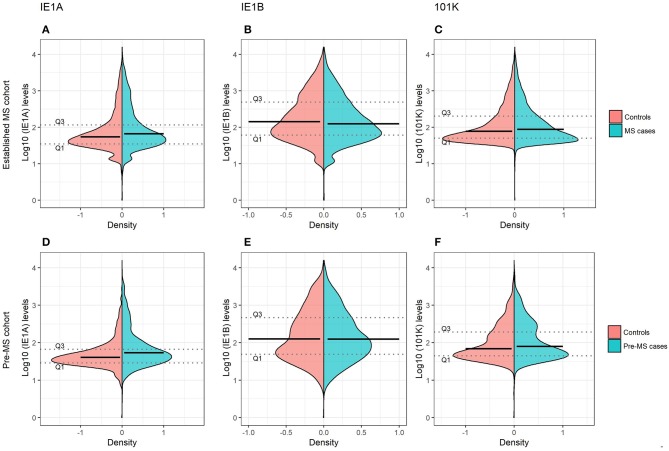
Antibody responses against HHV-6A and 6B proteins in MS cases and controls. Log10-transformed antibody levels measured as median fluorescence intensity (MFI) are visualized with bean plots for established MS cohort [n = 8,742 persons with MS (blue) and n = 7,215 controls (pink)] (A–C) and pre-MS cohort [n = 478 persons with MS (blue) and n = 476 controls (pink)] (D–F) for HHV-6A IE1A IgG (A,D); HHV-6B IE1B IgG (B,E); HHV-6B anti-101K IgG (C,F). The 1st and 3rd quartiles are indicated with dotted lines and solid lines indicate median.